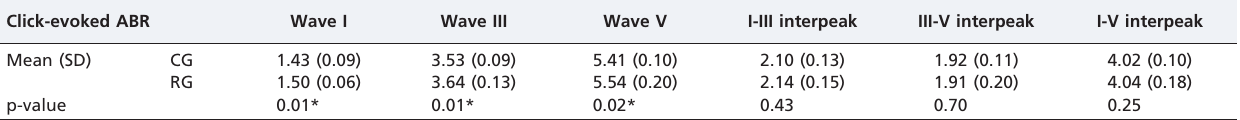
Table 1 - Control and Research Groups’ means and SD of waves I, III, V and I-III, III-V and I-V Interpeaks latency (ms) click- evoked measures.